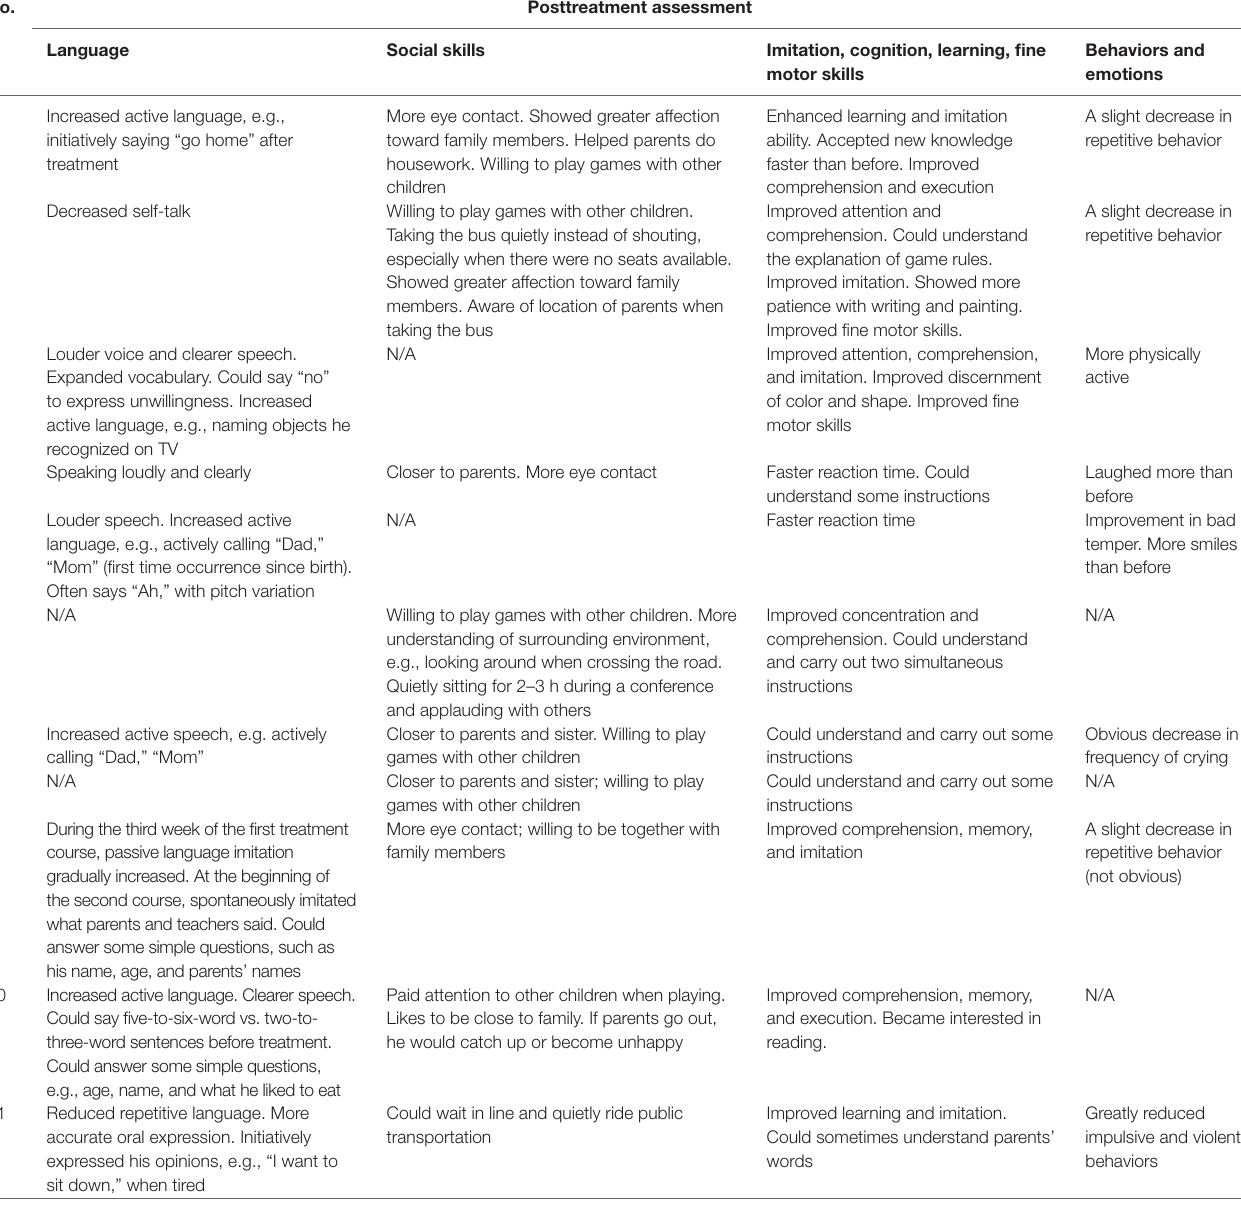
TABLE 4 | Improvements in the quality of life of 11 participants, following HF-rTMS treatments. Records from caregiver’s